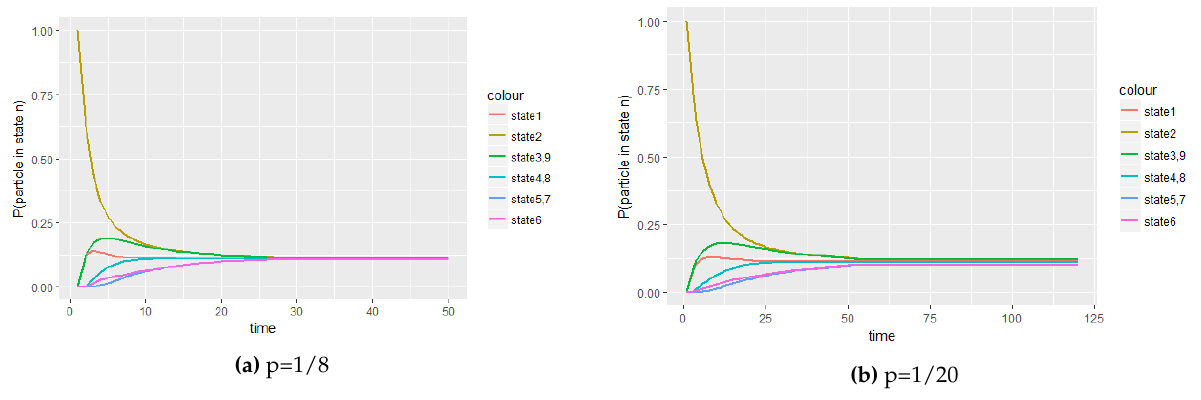
Figure 13. The panel of graphs to represent transitional probabilities against time interval of a transition matrix P with starting point at the one of the border corner cell with with initial probability vector P 0 ( 0,1,0,0,0,0,0,0,0 ) . From these figures state 3 and 9, 4and 8, 5 and 7 overlaps together to form new states respectively because they have the same stochastic behavior to the